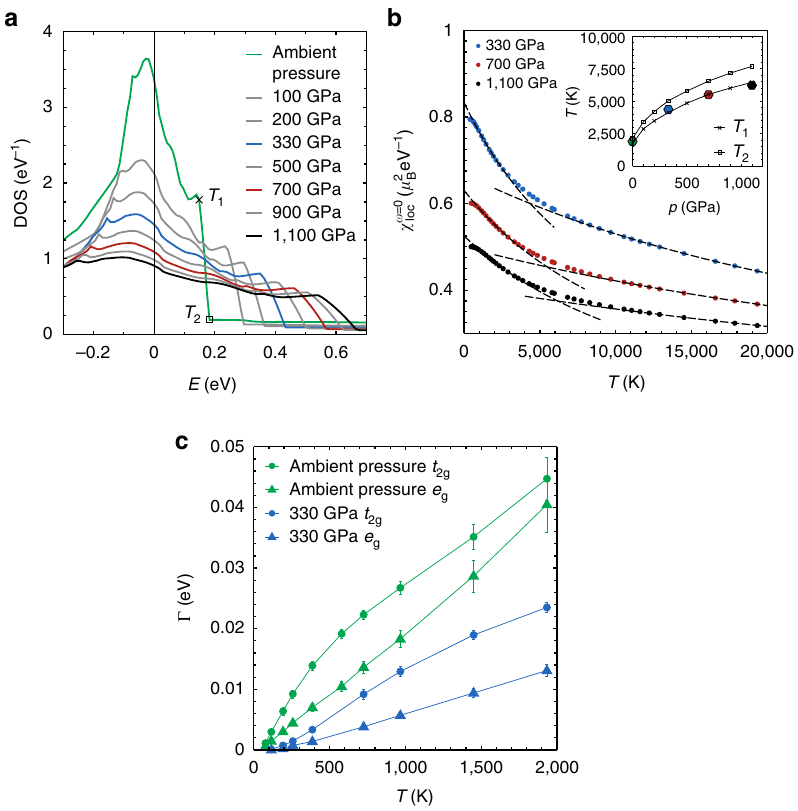
Figure 4 | Nickel under pressure. ( a ) The t 2g DOS of nickel at different values of the pressure. The van Hove peak and the sharp edge are smoothed with increasing pressure, but the Fermi level ( E F ¼ 0) remains close to these two singular points. The cross at temperature T 1 marks the beginning of the DOS steps, whereas the square at T 2 marks is its ending. Their evolution with pressure is shown in the inset to b . ( b ) Non-interacting local spin susceptibility versus temperature at high pressures. The dashed lines are least-square fits of the high- and low-temperature region, which uncover the separation between the two Wilson-like behaviours, shifting towards higher temperatures compared to ambient pressure. The position of this kink (shown as hexagons in the inset) scales with the energy distance between E F and the sharp edge of the t 2 g DOS. ( c ) A consequence of the sharp features at the top of the band is the deviation of the quasiparticle scattering rate from the T 2 law predicted by the Landau theory. Here this is shown for pure nickel, by plotting the scattering rates of one of the degenerate t 2g and one of the degenerate e g orbitals, both at ambient pressure and at 330GPa. The error bars come from averaging over different fit parameters (number of Matsubara frequencies and order of